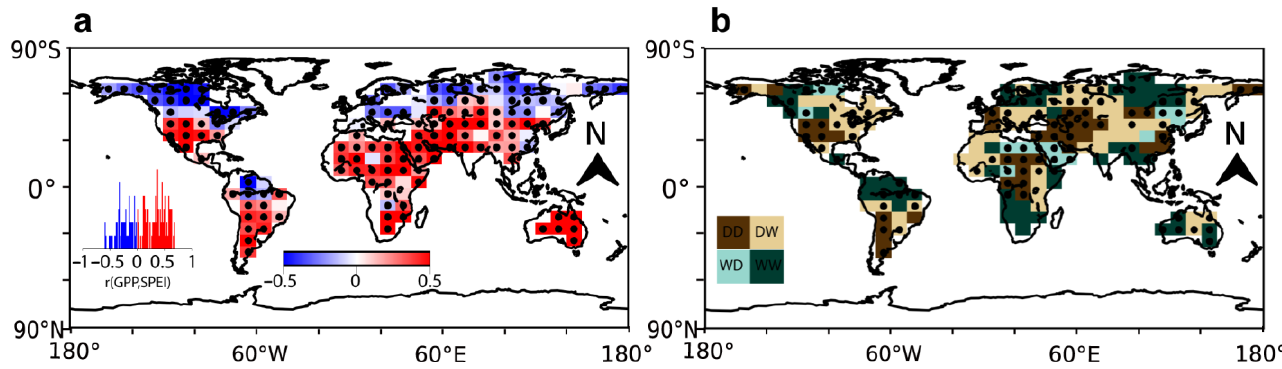
Figure 7. SPEI-9 correlation with CCDAS-GPP and the drought trend identified by SPEI-9. ( a ), Pear- son correlation between SPEI-9 and CCDAS-GPP over 1980 – 2015, dots denote significant correlation ( p < 0.05), the inset depicts the distribution of positive and negative correlations. (b), the dry/wet condition shift for each grid, dry or wet is defined when the mean value of the 9-month SPEI is